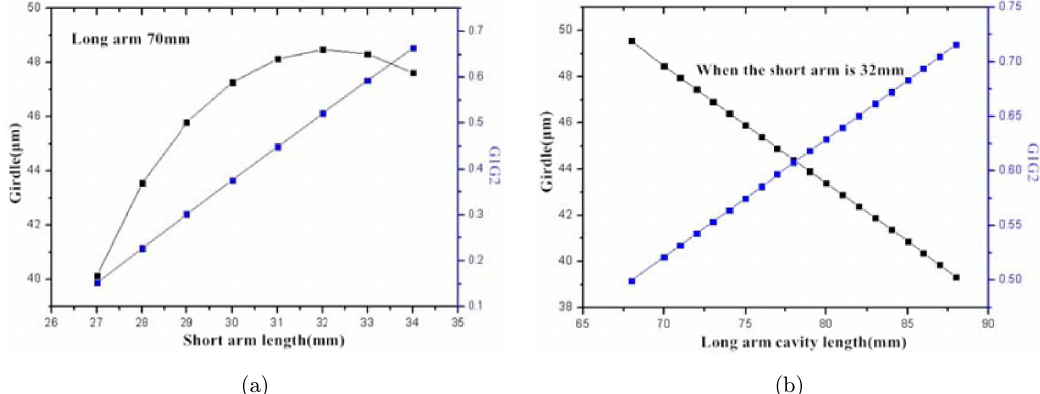
Fig. 3. Change in girdle length and G1G2 parameter with (a) increasing short arm length (at a ¯xed long arm length of 70 mm) and (b) increasing long arm length (at a ¯xed short arm length of 32 mm).